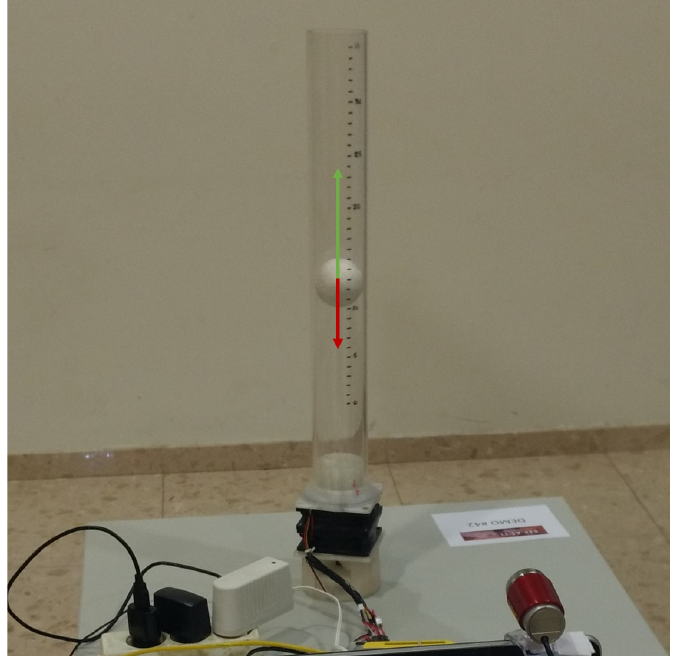
Figure 3. Balance of forces of the air levitation system used in the experiment. The red arrow shows the gravitational force, while the green arrow shows the force applied by the air flow.